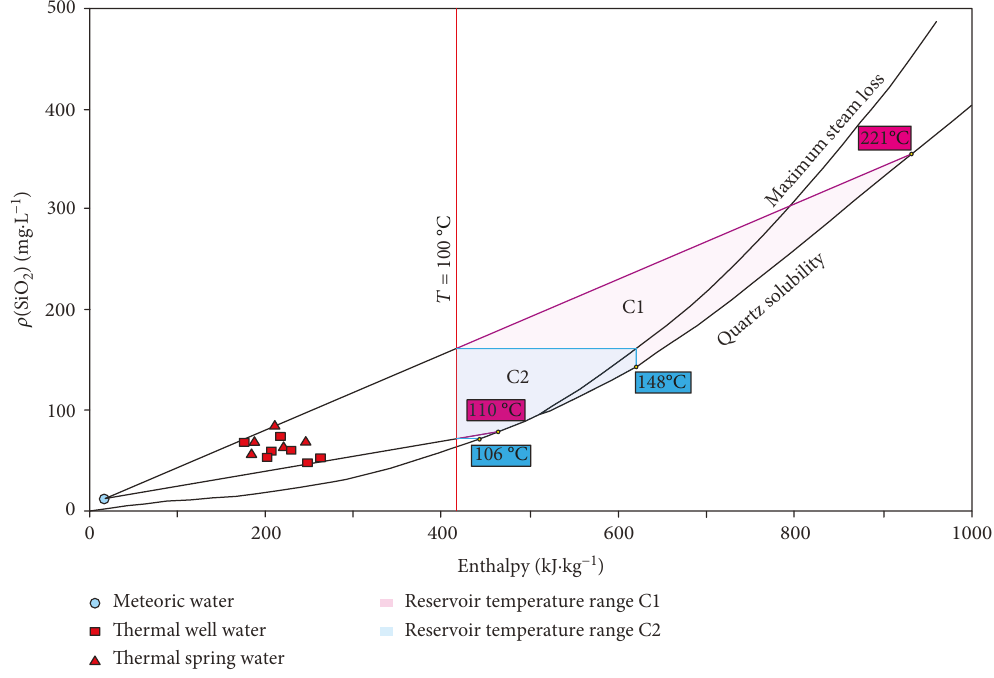
Figure 6: Silica vs. enthalpy mixing models of geothermal water samples in the research